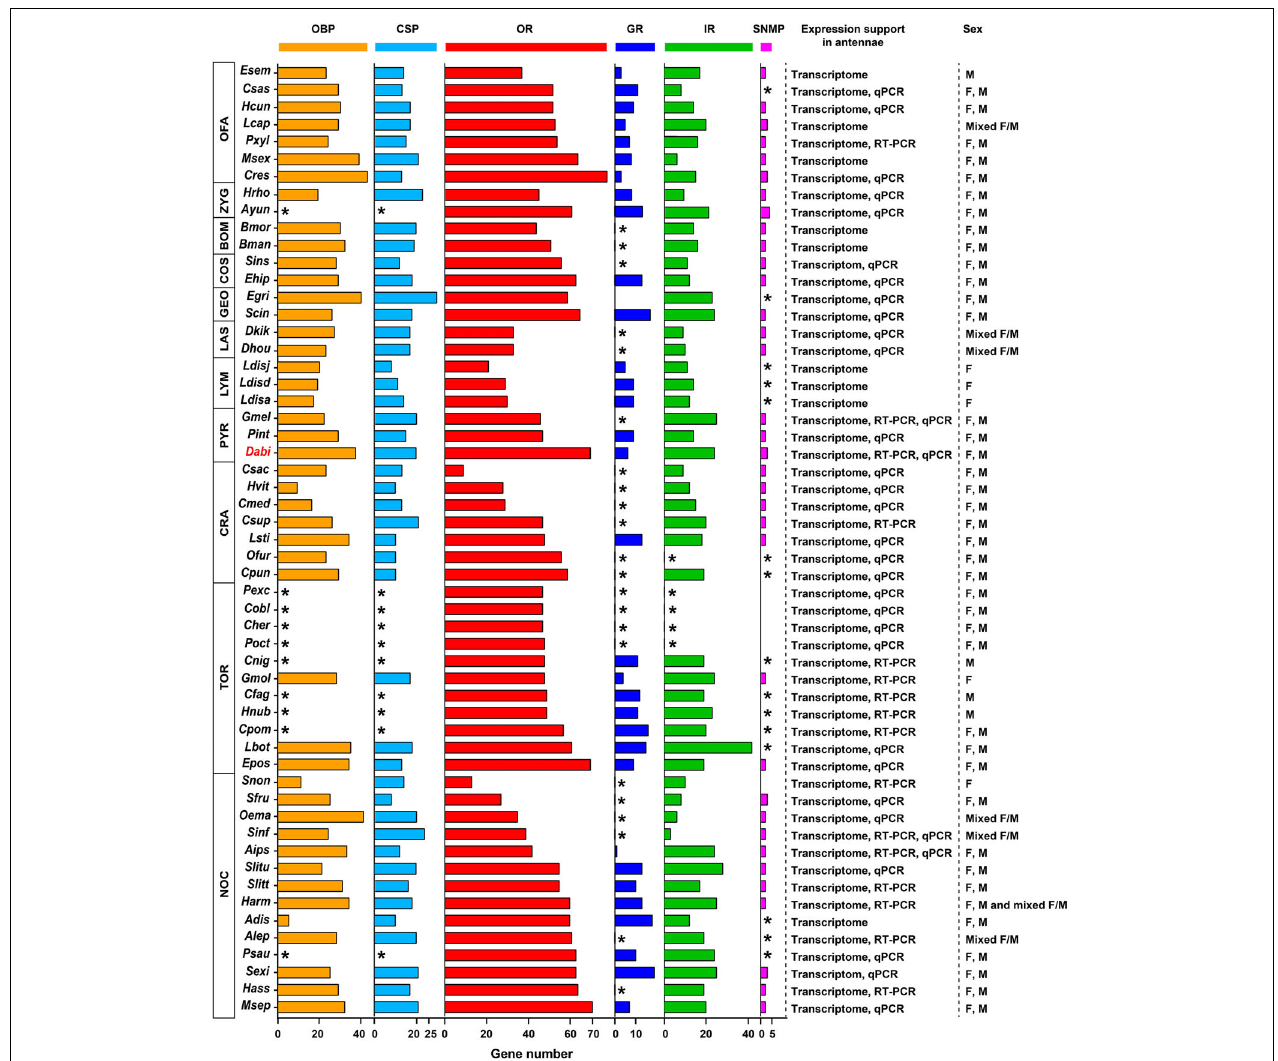
FIGURE 1 | Chemosensory gene repertoires of 55 lepidopteran species derived from antennal transcriptomes and PCR data. Based on RNA–Seq data and PCR results of genes in antennae, six chemosensory protein families of OBPs , CSPs , ORs , GRs , IRs, and SNMPs were counted. Asterisks represent that these genes were not reported in the corresponding studies. “F, M” represent that female and male antennae were sequenced by RNA–Seq, respectively; while “Mixed F/M” mean that a mixed sample of female and male antennae were sequenced. In addition to that, F or M represent that the antennal transcriptomes of only female or male moths were sequenced. BOM, Bombycidae including Bombyx mandarina and Bombyx mori (Qiu et al., 2018); COS, Cossidae including Eogystia hippophaecolus (Hu et al., 2016) and Streltzoviella insularis (Yang et al., 2019); CRA, Crambidae including Chilo sacchariphagus (Liu J. et al., 2021),